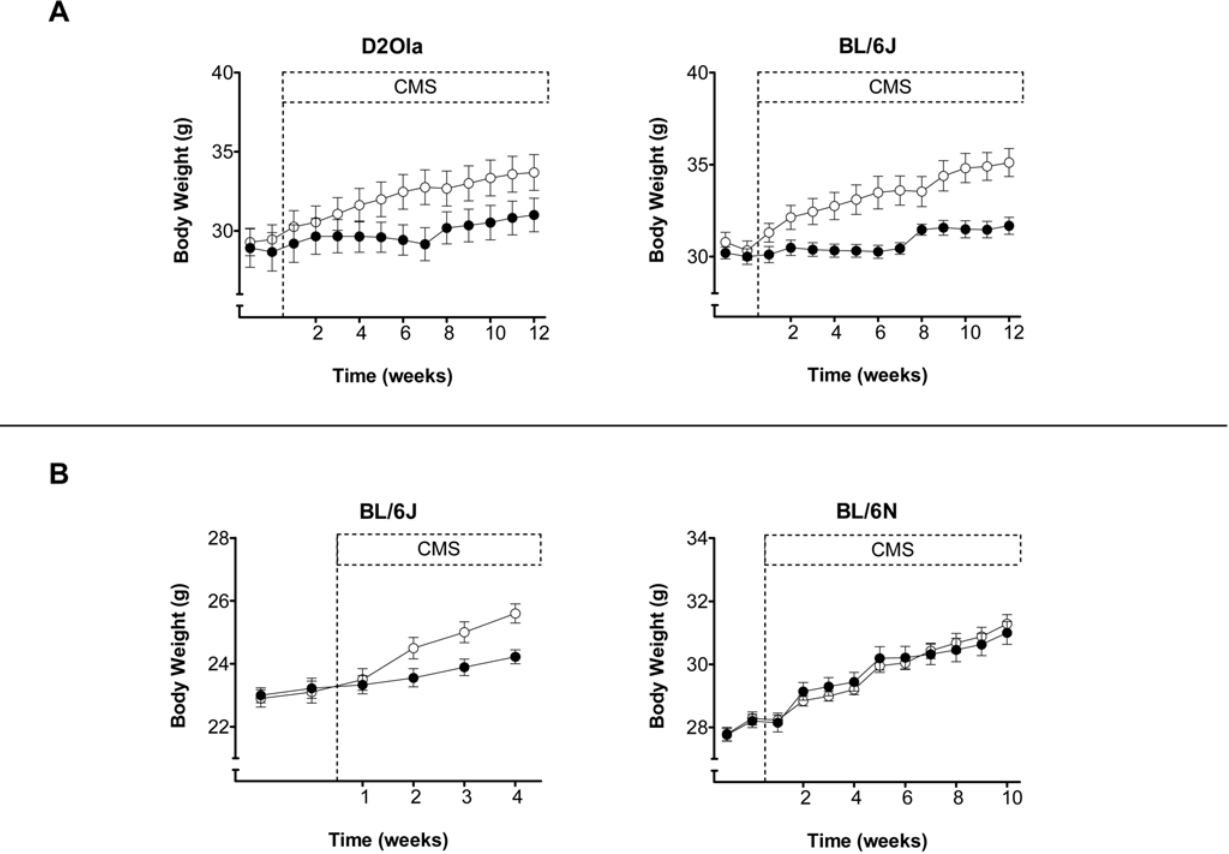
Figure 5. CMS effects on body weight. (A) The illustrated time courses of body weights are characterised by a flattened mean slope in CMS animals compared to controls, thus revealing a reduced body weight gain due to CMS in both D2Ola and BL/6J mice of the long-term CMS experiment. (B) In the shorter CMS experiments a similar reduction of body weight gain due to CMS could be observed in younger BL/6J but not in BL/6N animals. Data represent mean 6 SEM, n=9–20/group. White circles: control group, black circles: CMS group.